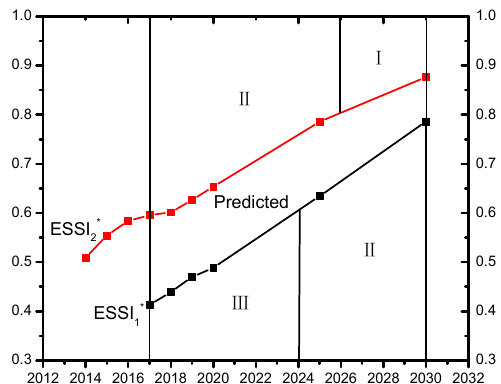
Figure 8. Forecasting results for China’s energy supply sustainability.